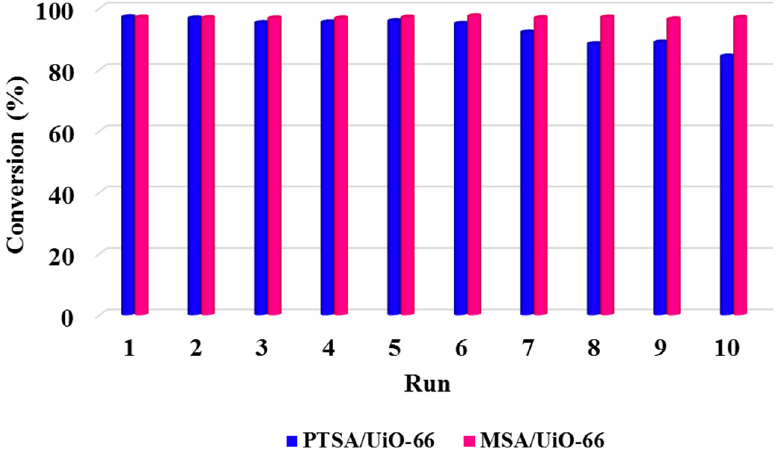
Figure 7. Reusability of solid catalysts in the esterification of PA with methanol.